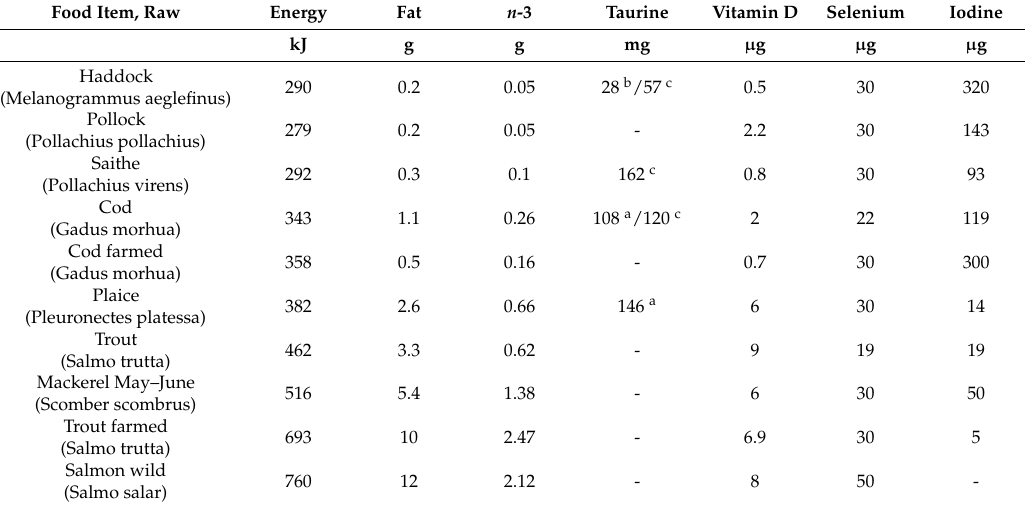
Table 5. Nutritional profile of commonly consumed, whole, raw fish, per 100 g